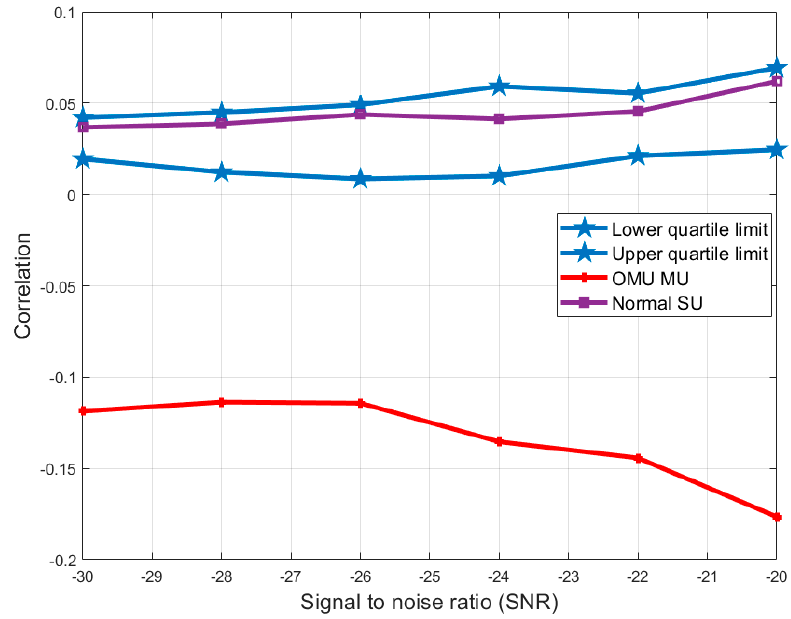
Figure 3. Correlation vs. signal-to-noise ratio (SNR), when an opposite malicious user (OMU) exists in the network.